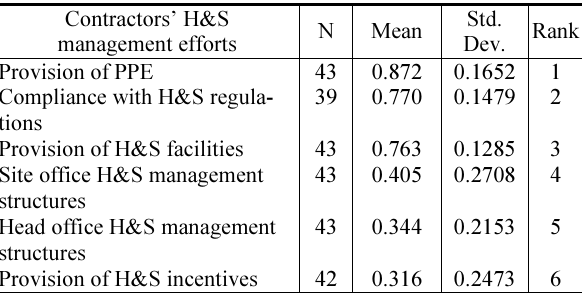
Table 1. Ranking of the level of contractors’ H&S